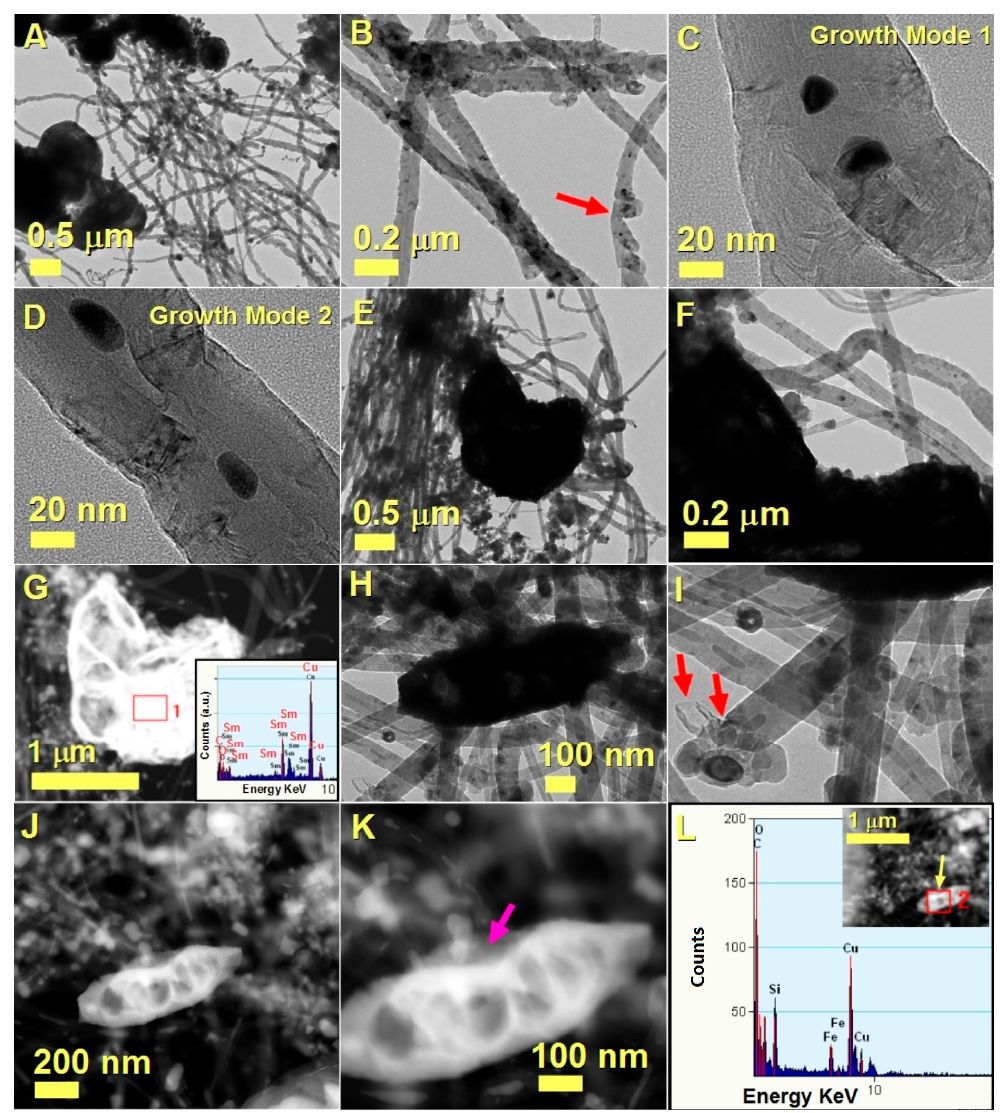
Figure 3. Transmission electron microscopy (TEM) ( A – F ) and high resolution TEM (HRTEM) ( C , D ) micrographs showing the cross sectional morphology of the CNTs comprised in the buckypaper. In ( G ), the STEM/EDX analysis of a micrometre-size catalyst particle showing the presence of both Sm and O (see inset) is shown. In ( H – K ) TEM ( H , I ) and STEM ( J , K ) micrographs showing the growth mechanism of a filled CNT departing from a SBA-16 flake are shown (see also magenta arrow in ( K )). The red arrows in I show also the nucleation mechanism of another CNT detached from the SBA-16 support. The EDX analysis of the area in ( K ) is shown in ( L ) (see also yellow arrow in inset). See Supplementary Materials Figure S1 for statistical investigation of the CNTs diameter and for more information on the CNTs